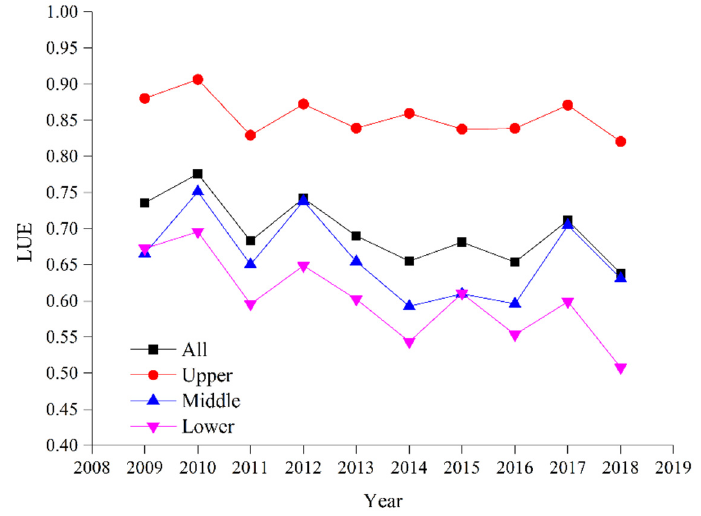
Figure 4. Mean of LUE for the whole of the Yellow River Basin and for the three regions from 2009 to 2018.